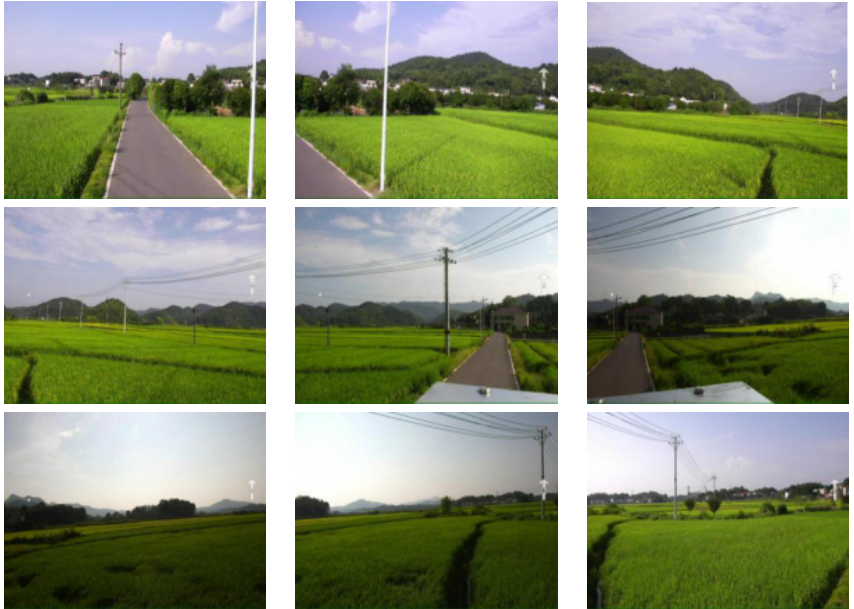
Figure 34. Images captured by the experimental vehicle. The FoV of the camera is 50 ◦ and each image was captured every 40 ◦ rotation of the camera. The resolution of each image is 1920 × 1080. It can be seen that there are some overlaps between the adjacent images.